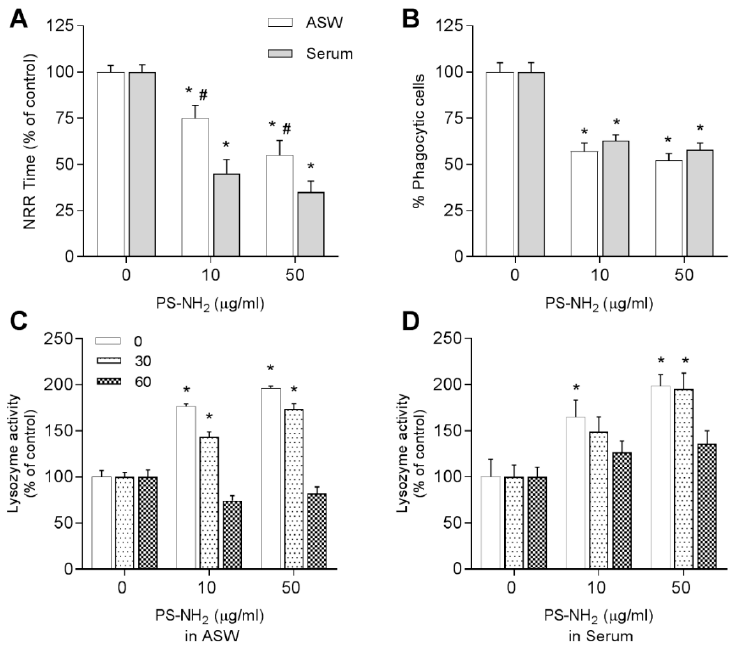
Figure 7. Effects of PS ‐ NH 2 in different suspension media in ASW (white bars) or hemolymph serum (HS) (grey bars) on mussel M. galloprovincialis hemocytes. ( A ) LMS; ( B ) phagocytosis;